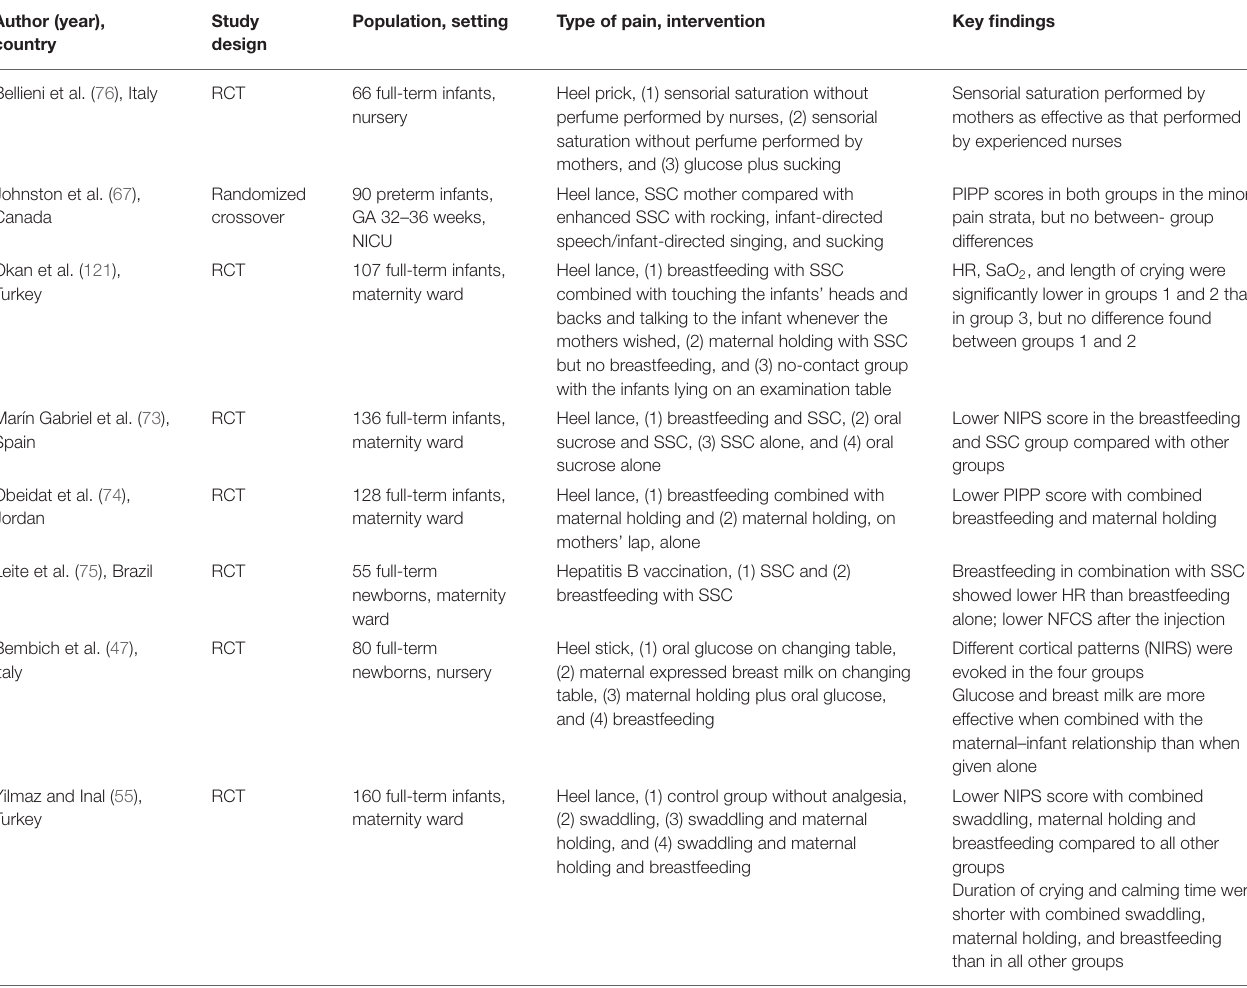
TABLE 8 | Evidence for parent-delivered interventions: combined parent-delivered interventions.